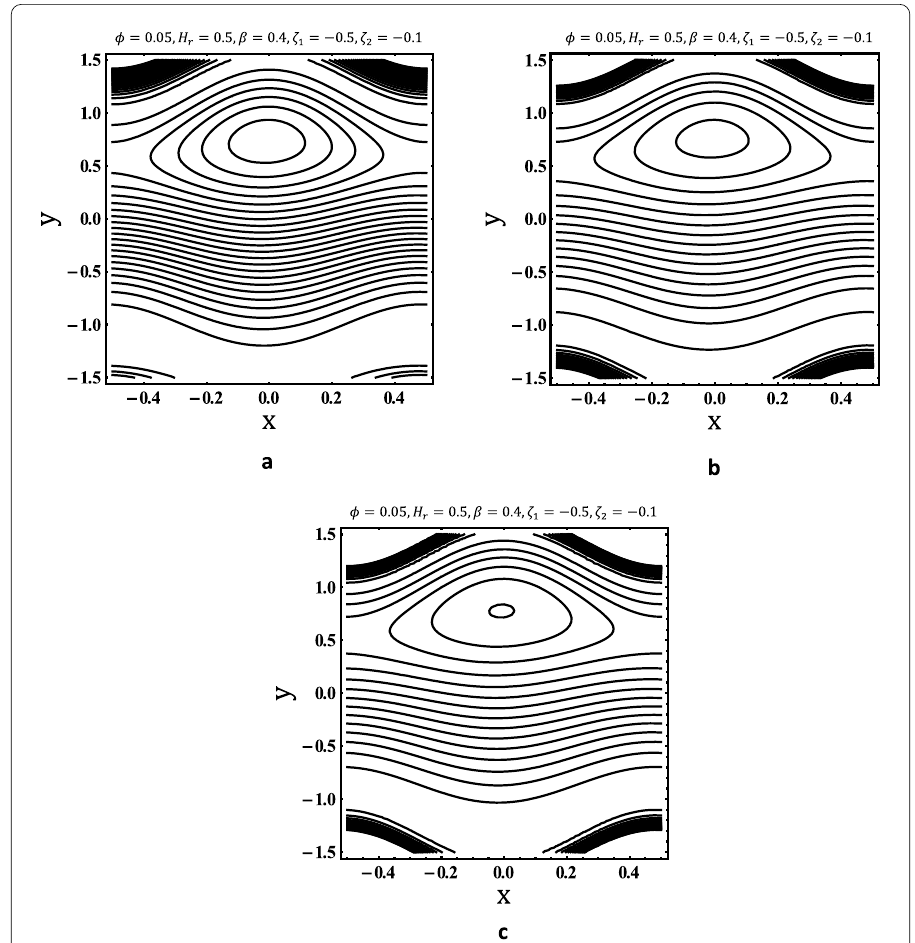
Figure 6 Streamline distribution for: ( a ) m = 5.0, ( b ) m = 10, and ( c ) m =